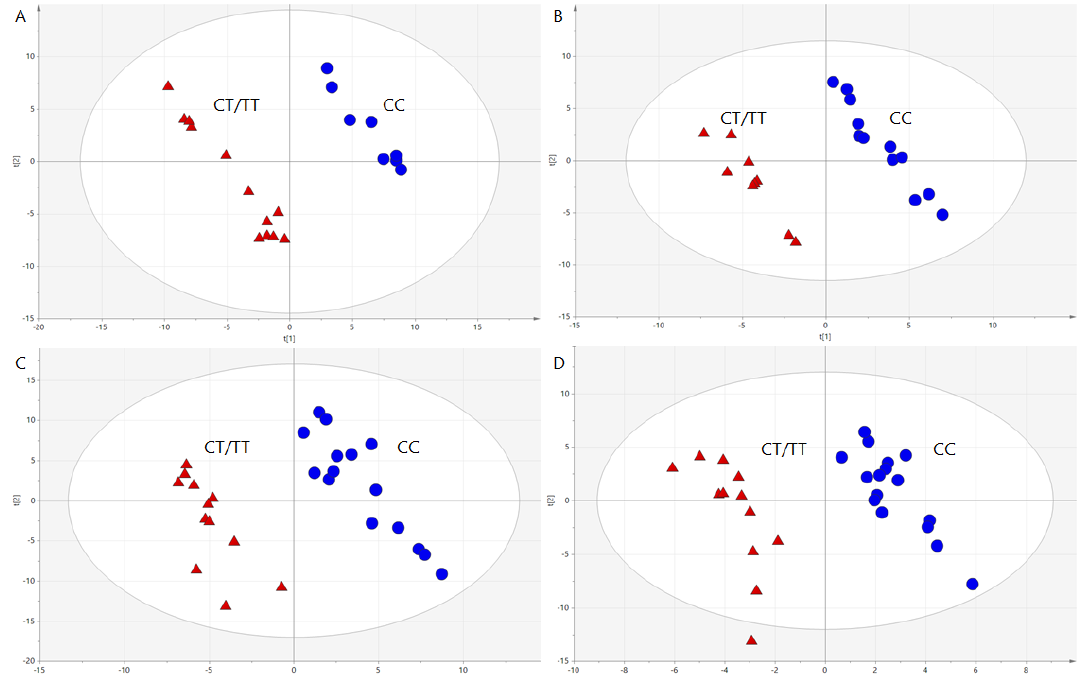
Figure 2. PLS-DA models computed based on AUCs of plasma metabolites illustrating clear separation between men carrying CC (blue dots) and CT / TT (red triangles) genotypes after NC-meal for ESI + ( A ) and ESI- ( B ), and HC-meal for ESI + ( C ) and ESI- ( D ). The parameters of the models: R2 = 0.989, Q2 = 0.279 for NC-meal for ESI + ; R2 = 0.989, Q2 = 0.433 for NC-meal for ESI-; R2 = 0.947, Q2 = 0.490 for HC-meal for ESI + ; R2 = 0.943, Q2 = 0.109 for HC-meal for ESI-. R2 = explained variance, Q = predictive capability of the